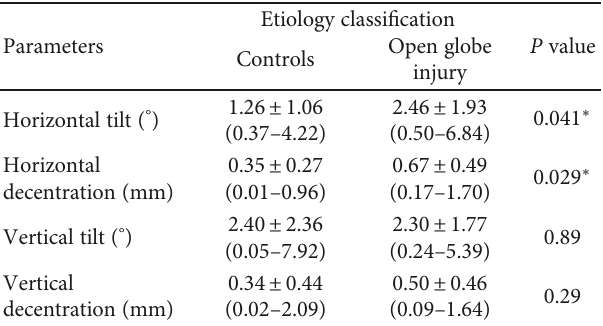
Table 2: Tilt and decentration 1 month after IOL implantation.